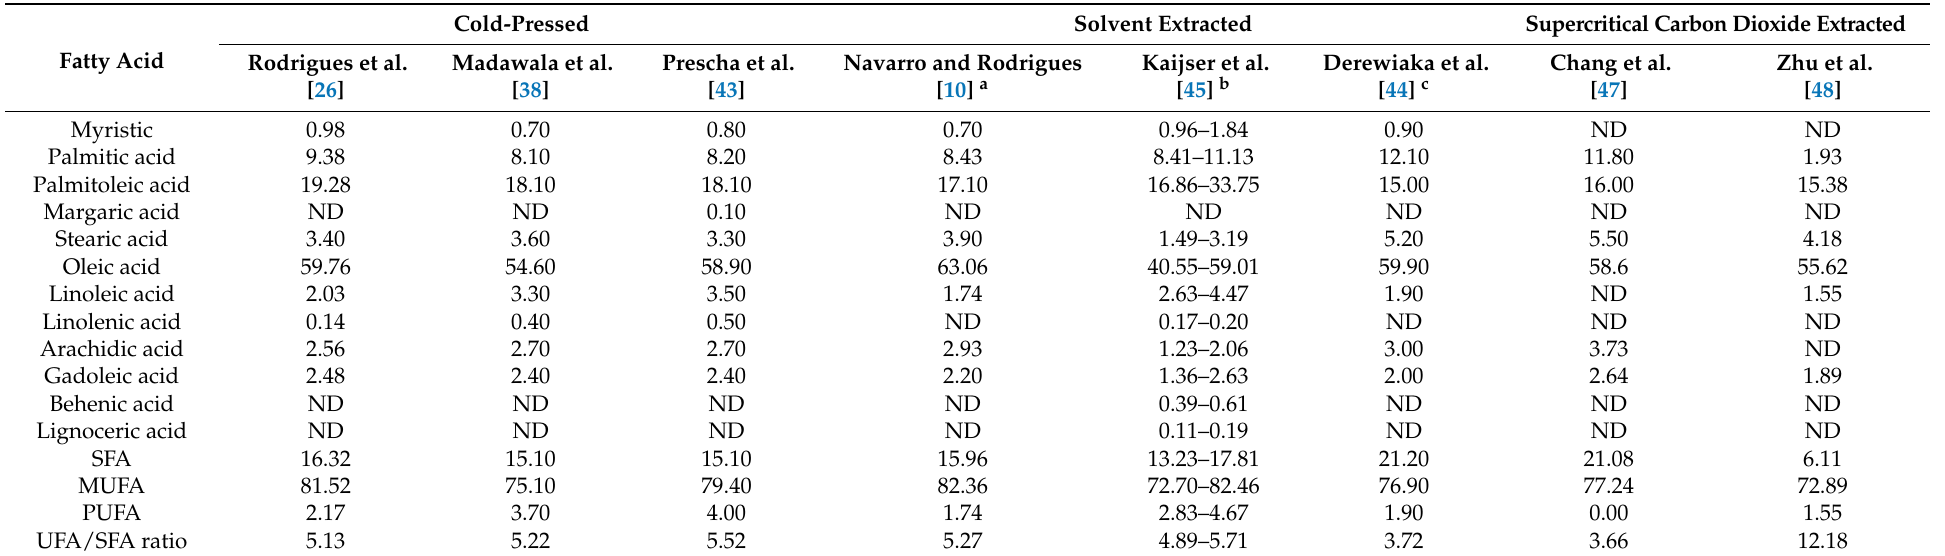
Table 3. Comparison of fatty acid composition (%) of cold-pressed, solvent, and supercritical carbon dioxide extracted macadamia nut